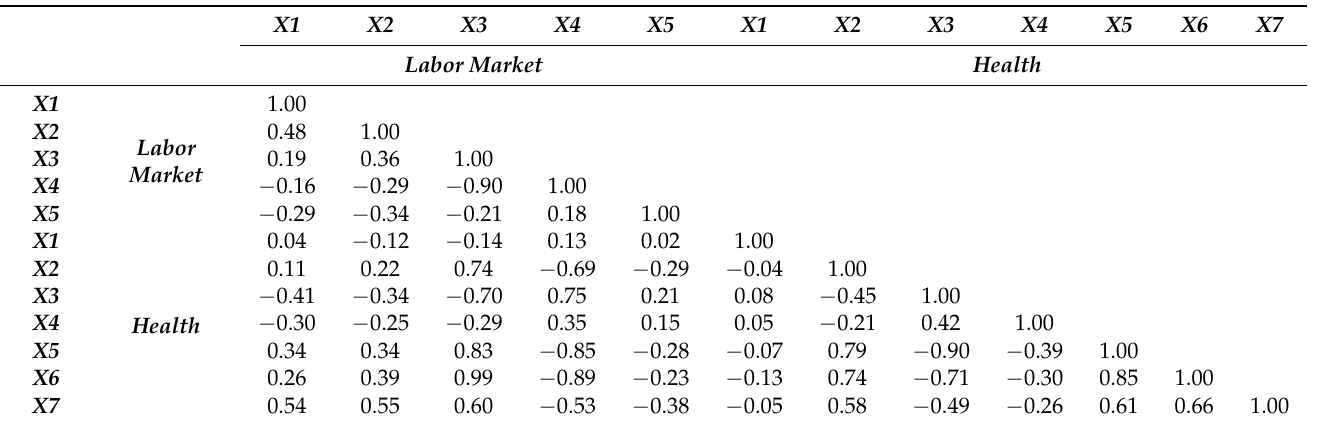
Table 4. Empirical variables—Pearson correlation